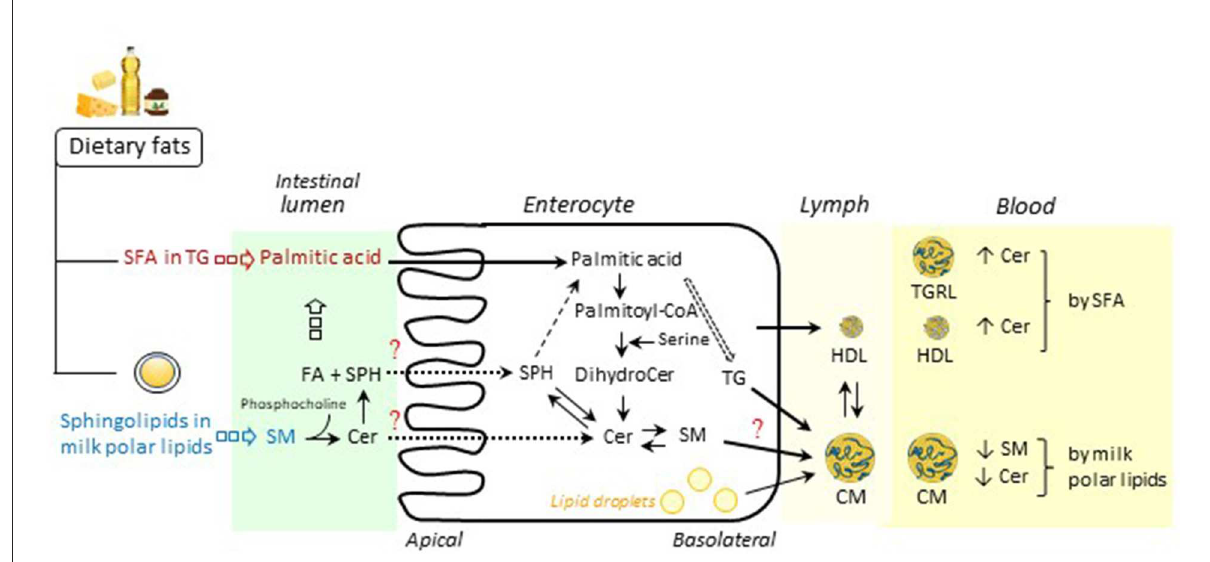
FIGURE1 Schematic overview of postprandial intestinal metabolism of dietary lipids, especially sphingolipids. Following ingestion of dietary fats, triglycerides (TG) including saturated fatty acids (SFA) are digested in the intestinal lumen by pancreatic lipases into 2-monoacylglycerols and unesterified fatty acids (FA) (e.g., palmitic acid), which are then absorbed in the enterocytes, resynthesized as TG and packaged into chylomicrons (CM) for secretion into lymph. In the enterocyte, condensation of palmitoyl-CoA and serine by serine palmitoyltransferase (SPT) produces dihydroceramide (dihydroCer) and Cer. Among milk polar lipids including sphingolipids, sphingomyelin (SM) is hydrolyzed by an alkaline sphingomyelinase to ceramide (Cer) and phosphocholine. Cer is further hydrolyzed by a neutral ceramidase into sphingosine (SPH) and FA. In the enterocyte, SPH is mainly converted to palmitic acid, which is incorporated into TG but may be reincorporated into Cer and complex sphingolipids. Intestine-derived lipoproteins, i.e., CM, the major triglyceride-rich lipoproteins (TGRL) and HDL, are released into the bloodstream via the lymph. As described in the present review, SFA consumption may lead to increased concentrations of Cer in TGRL (28) and HDL (33). Supplementation with milk polar lipids may result in decreased concentrations of SM and Cer in CM (27). Future research should study the endogenous metabolism of sphingolipid species in enterocytes. Some figure elements were obtained from Servier Medical Art (https://smart.